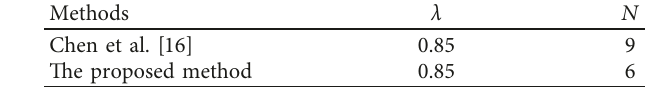
Figure 5: Trajectories of the players with strategy equation (17) without maintaining the formation ( N � 6, λ � 0 . 85). The evader escapes successfully.